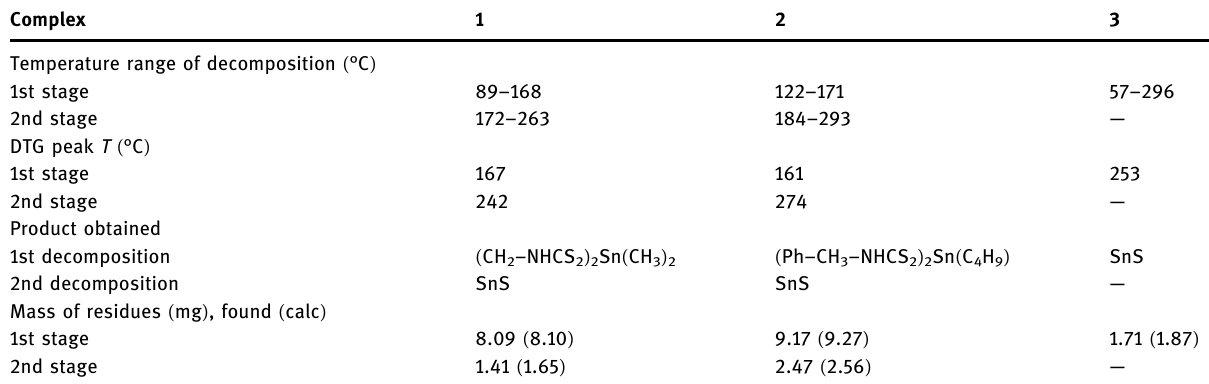
Table 1: Thermal analysis data of complexes 1 –